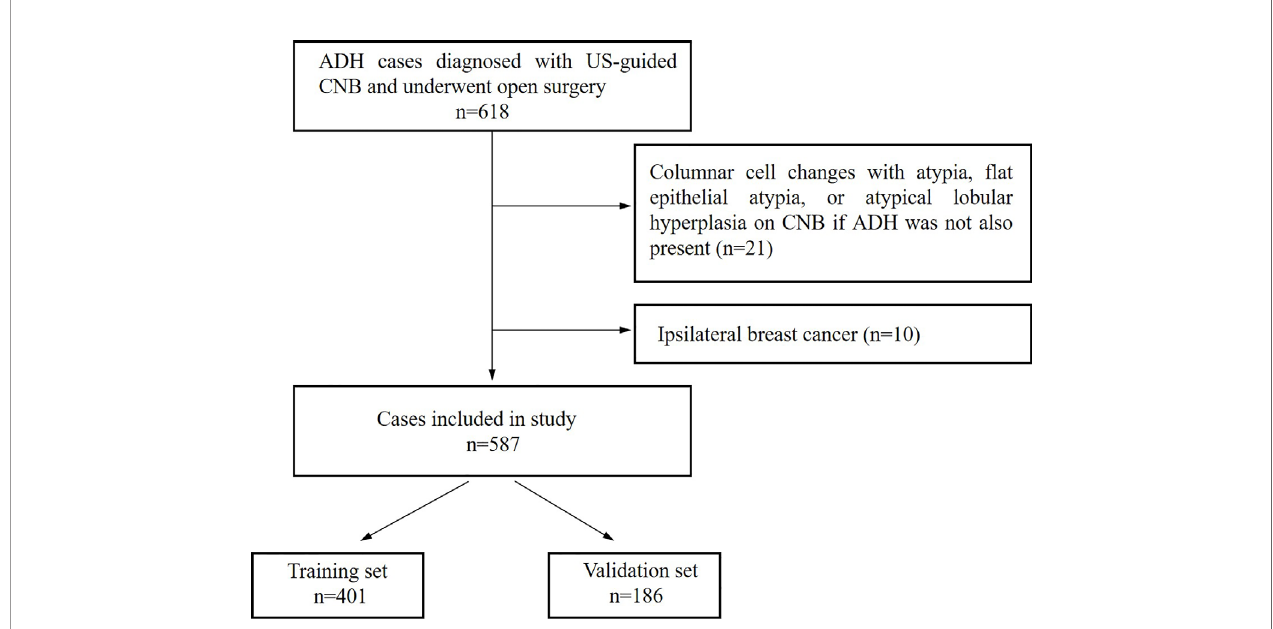
FIGURE 1 | Flow chart of cases selection from atypical ductal hyperplasia (ADH) cases diagnosed between January 2014 and December